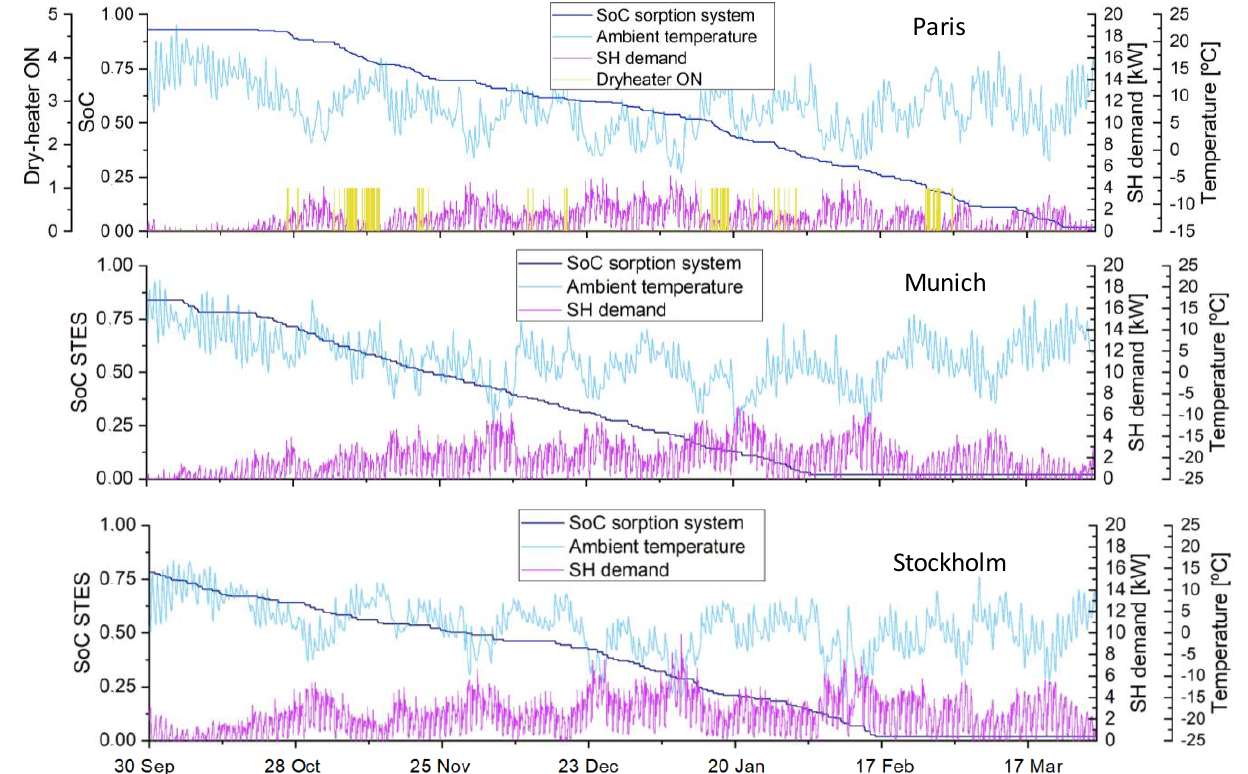
Figure 11. Variables of Paris, Munich, and Stockholm during winter (from October to March).